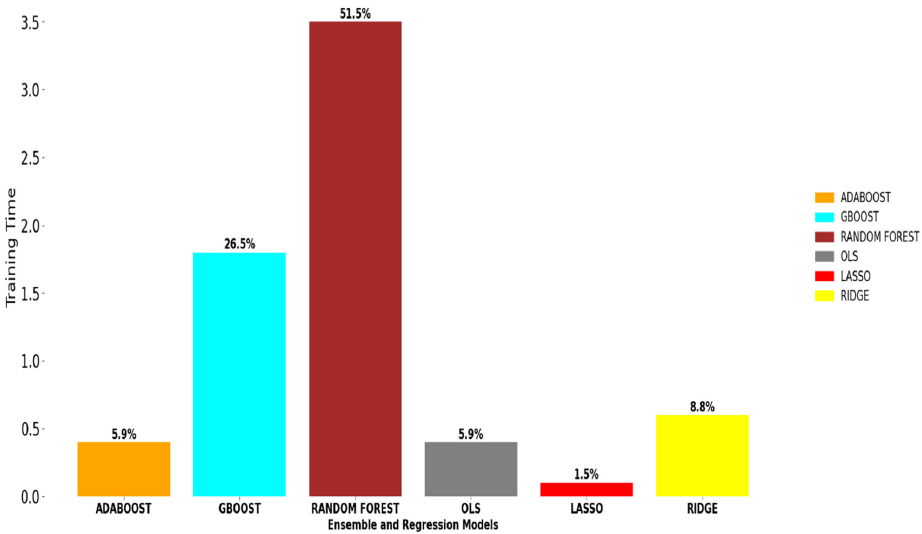
Figure 8. Comparison of Training time of machine learning.